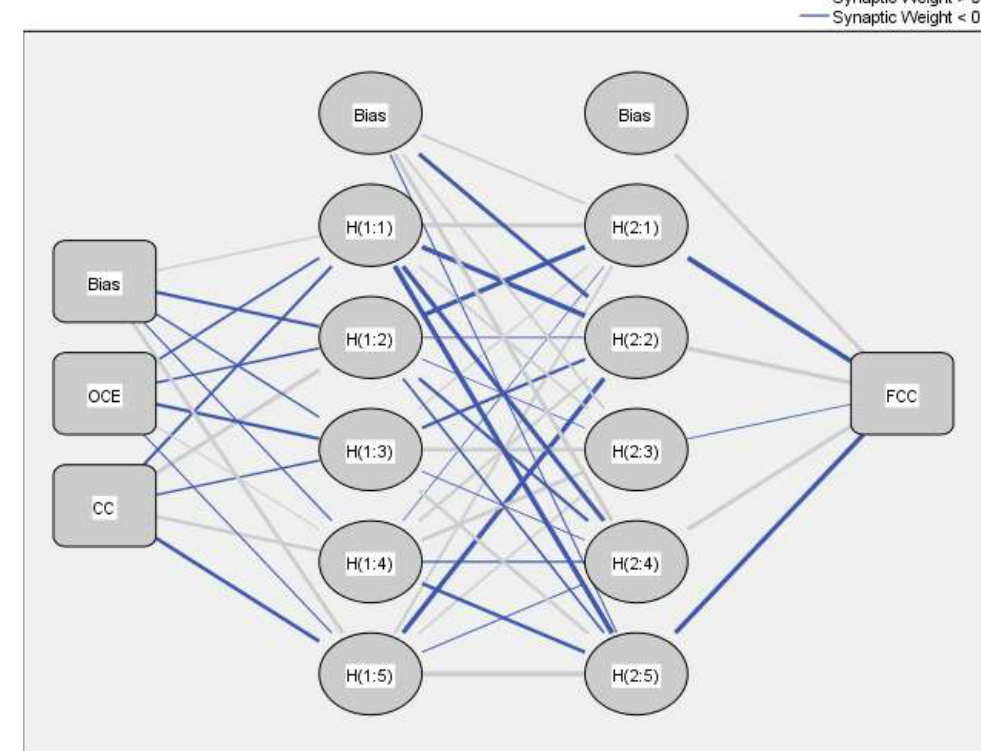
Figure 6. The ANN structure.